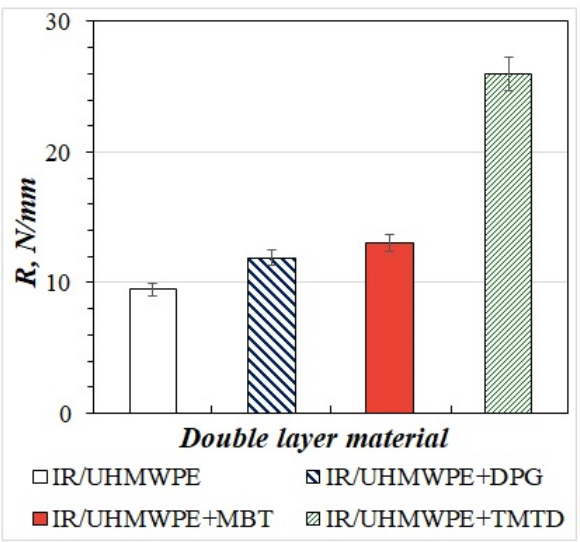
Figure 6. Cohesive nature of delamination of two-layer materials (e.g.,: elastomer/UHMWPE-TMTD).